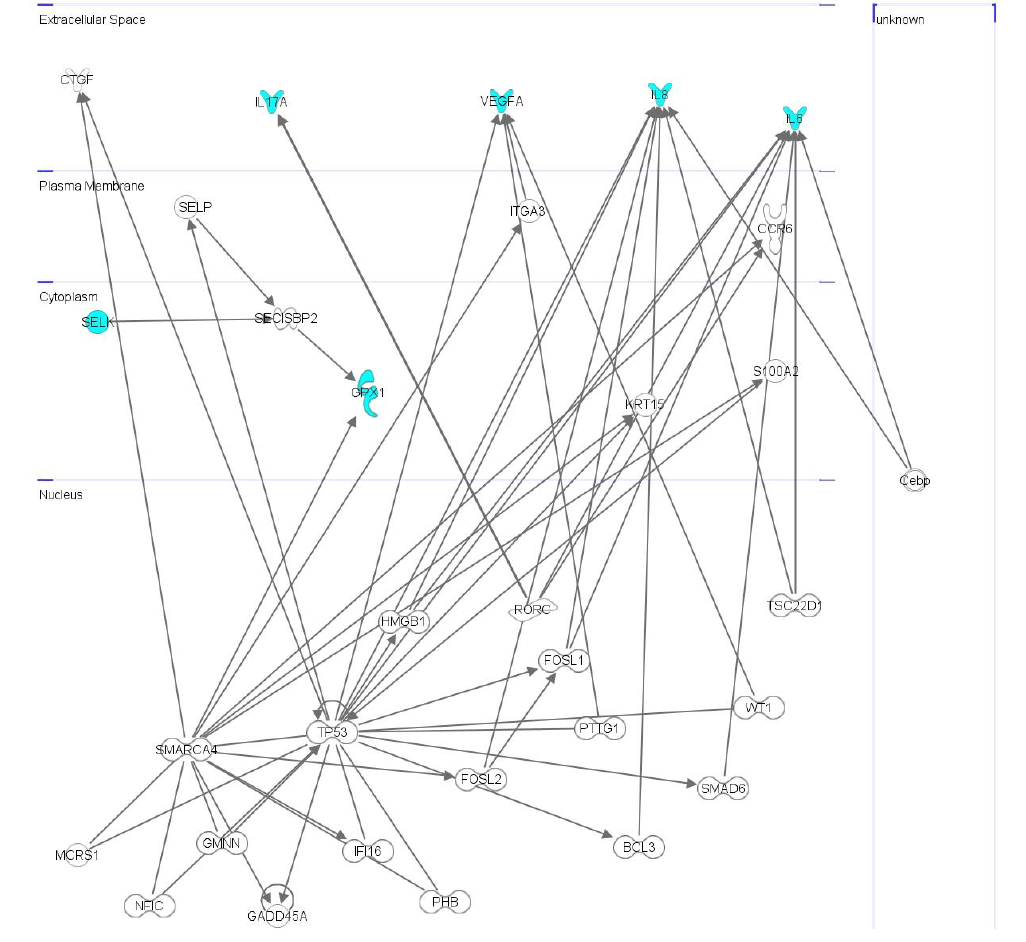
Figure 6. Interactomic analysis by Ingenuity Pathway Analysis (IPA) of significant molecules. The interactome shows the close functional association between SELK, GPX1 and significant cytokines, (evidenced with cyan symbols) as well as the paths in which other functionally relevant molecules are also involved (evidenced with white